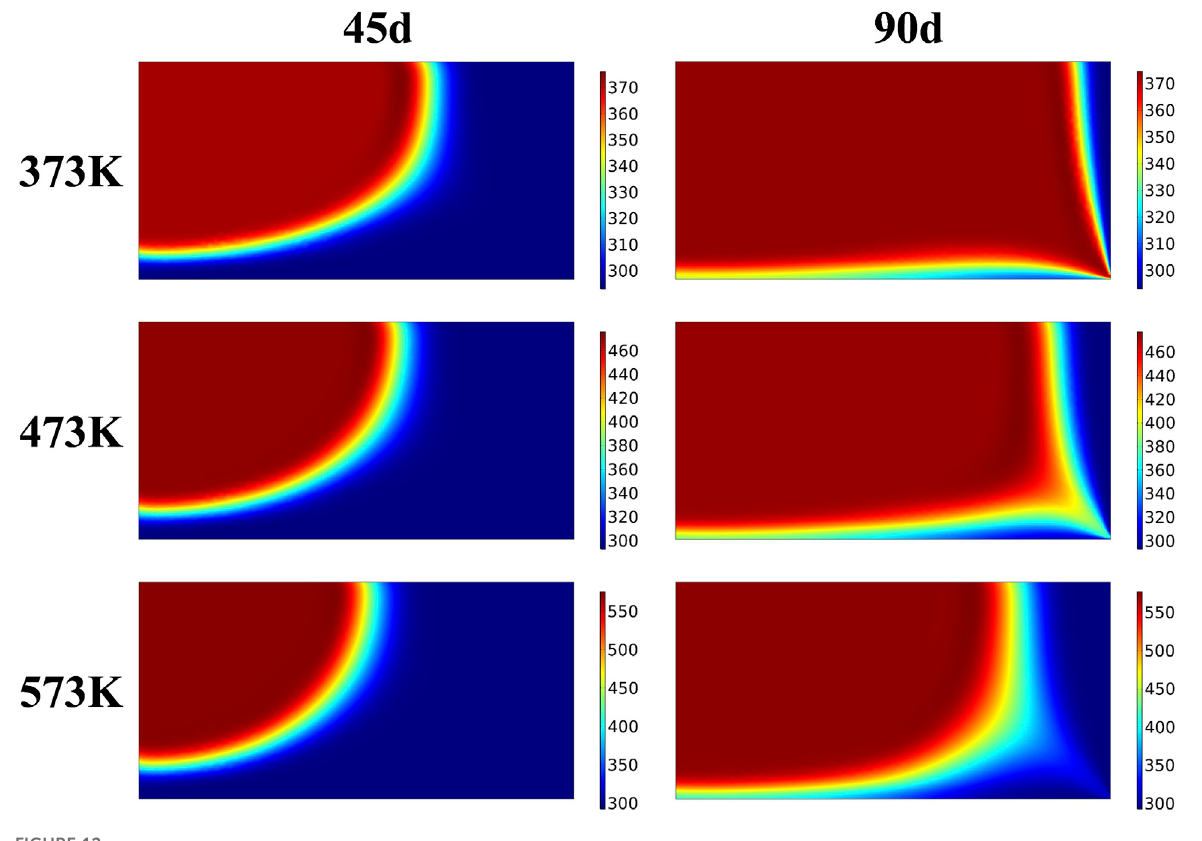
FIGURE 12 Temperature distribution of the system during heat injection at different injection